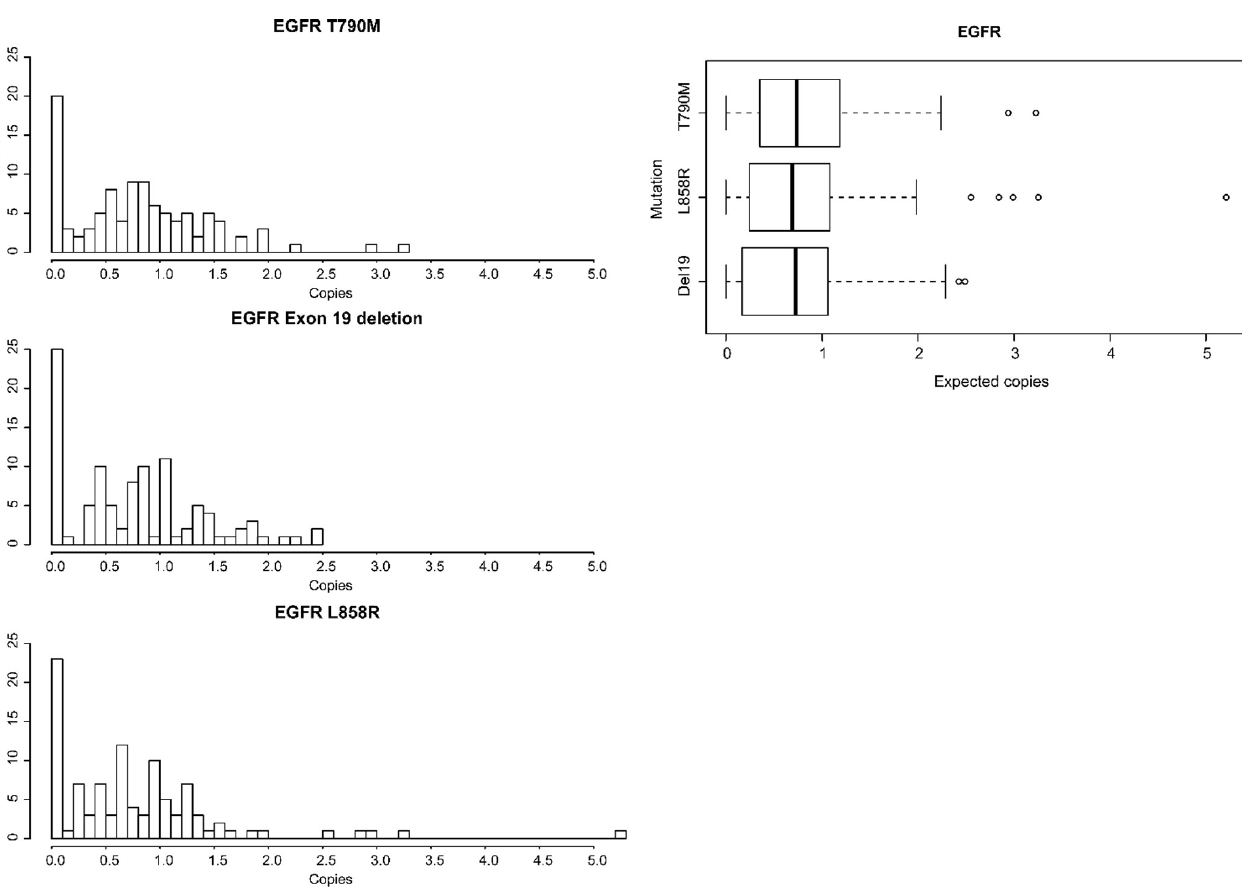
Fig 4. Test of repeatability at the low mutant copy level—estimation of the actual number of mutant copies in each of 102 aliquots containing theoretical 1 copy of spiked mutant. A. Histograms showing the frequency and distribution of mutant copies detected in 102 replicates for assays. B. Boxplot showing the collectively recovered number of copies by the three assays and thereby the overall detected copy number by assays. Abbreviations: EGFR, Epidermal growth factor receptor.